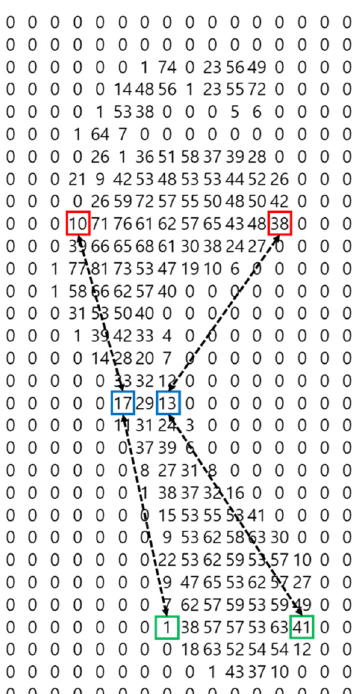
right side is concave, so deviation will be large. Based on these characteristics, the foot classification